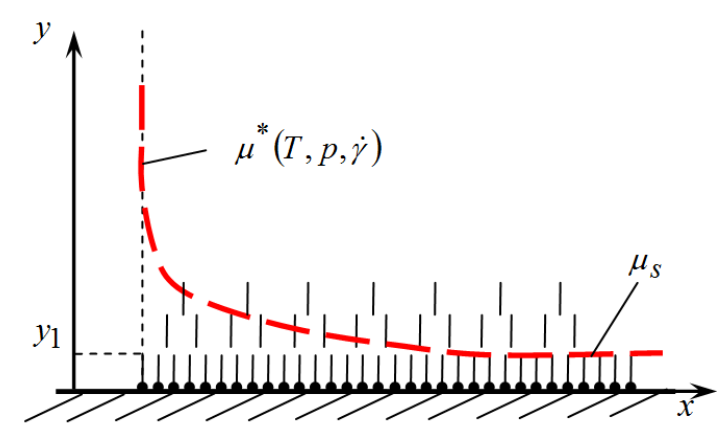
Figure 3. Lubricant viscosity change over layer thickness.